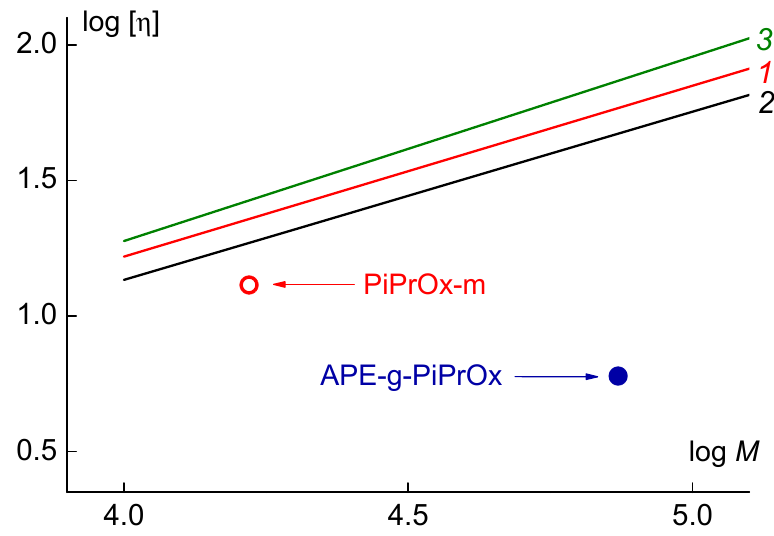
Figure 6. Intrinsic viscosity [ η ] vs. molar mass M for the studied polymers in nitropropane (data points), and Mark–Kuhn–Houwink–Sakurada (MKHS dependences for linear poly(2-ethyl-2-oxazoline) (PEtOx) (lines 1 [58] and 2 [59]) and poly(2-methyl-2-oxazoline) (PMeOx) (line 3 [58]).